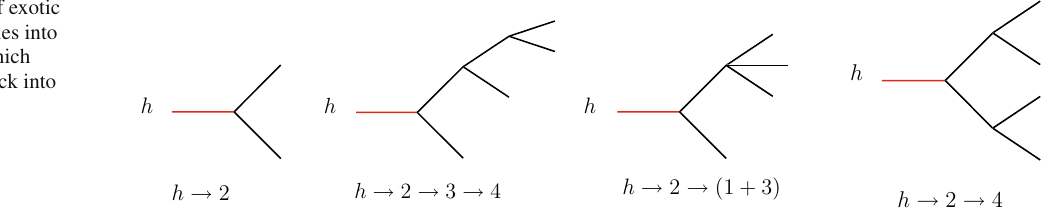
Fig. 15.1 Selection of exotic Higgs decay possibilities into hidden sector states which